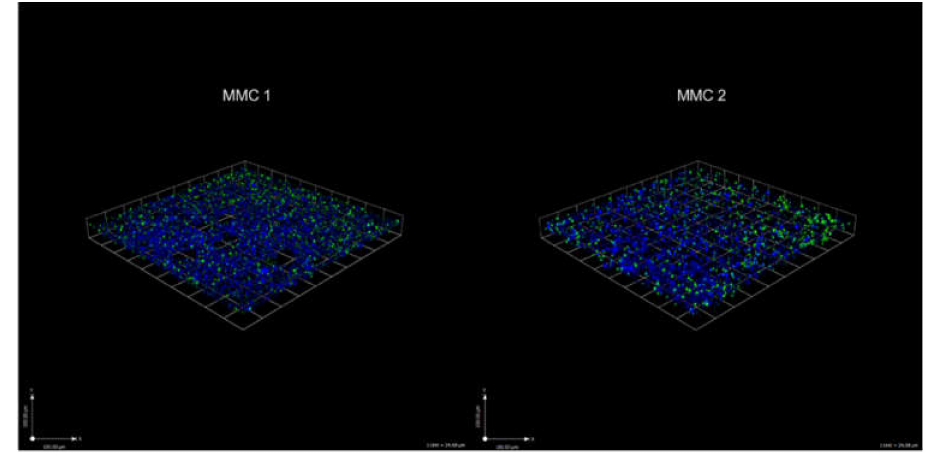
Figure 7. C. auris biofilms grown for 48 h and treated with 200 µ L of blank-np (1 mg / mL) for 24 h. C. auris biofilm stained with calcoflour (cell wall: blue) and Syto-9 (blank-np: green). Scale bar represents 100 µ